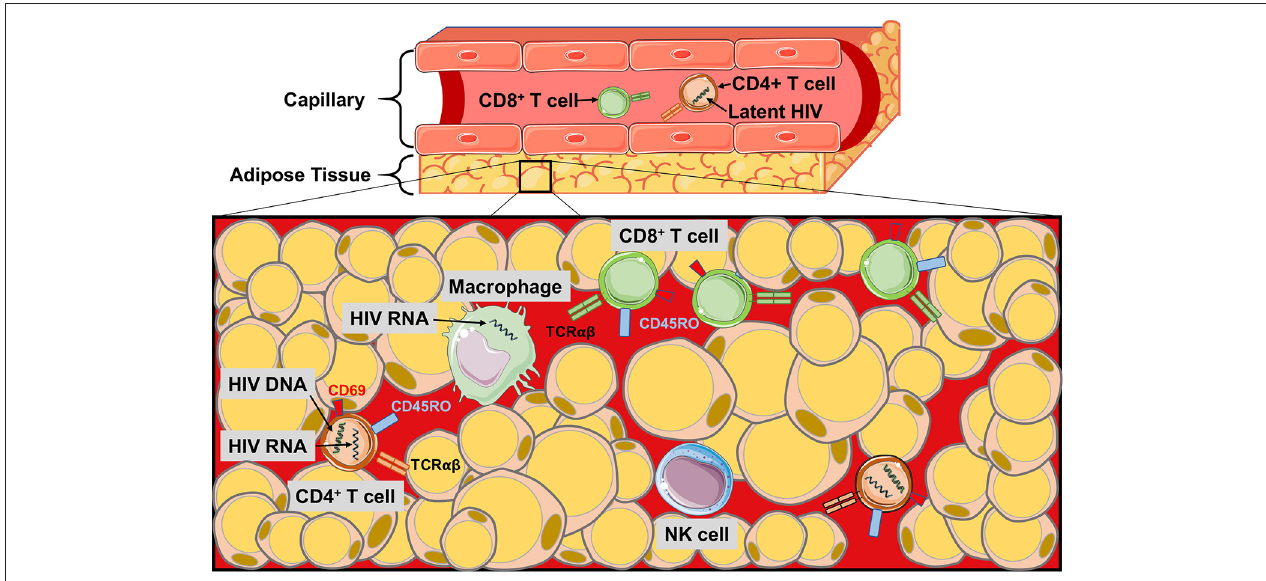
FIGURE 2 | The HIV/SIV viral reservoir in adipose tissue. Schematic of the immune cell populations in PLWH and SIV-infected primates where latent and replicating HIV and SIV have been identified. HIV RNA and proviral DNA has been detected in the CD4 + T cells of the SVF, and also in macrophages during SIV infection. Poor perpetration of some antiretroviral agents into adipose tissue and the distance of CD4 + T cells from the pericapillary area may make targeting the latent reservoir of adipose CD4 + T cells difficult. Similarly, the localization of the CD8 + T cells to the pericapillary area may prevent cytotoxic killing of HIV-infected CD4 + T cells in the adipose